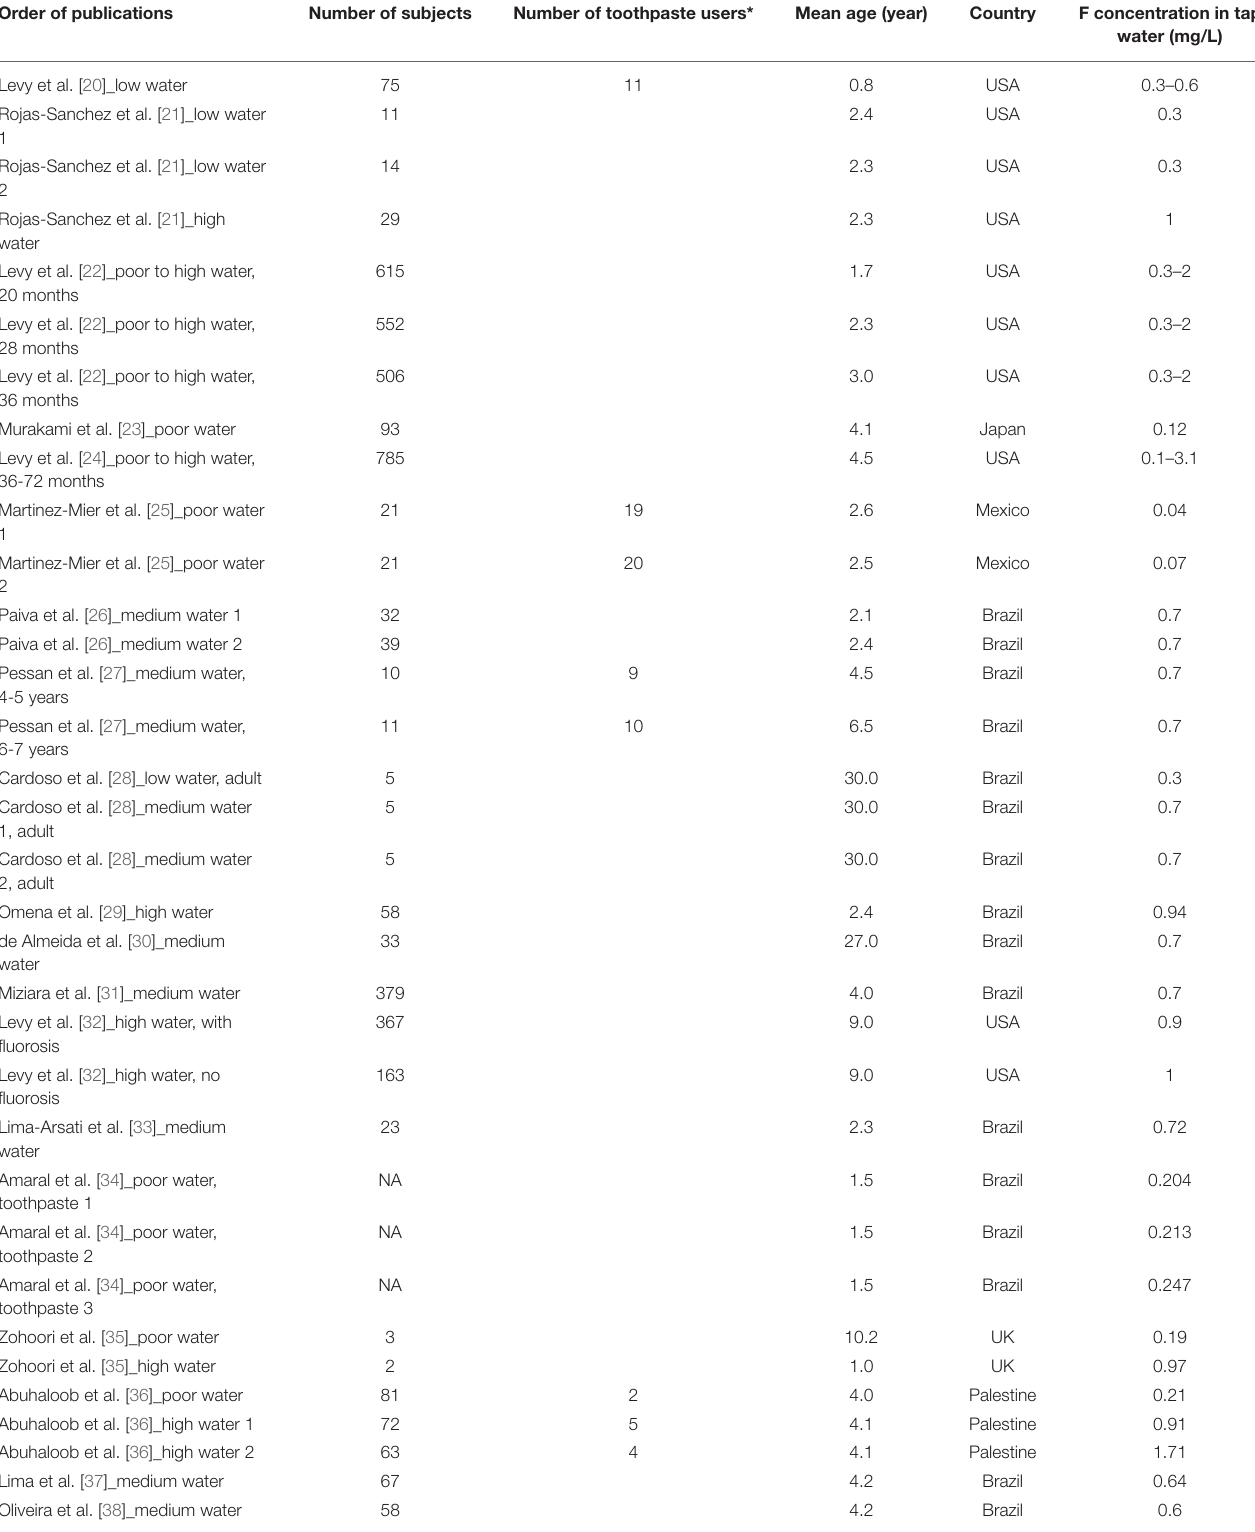
TABLE 1 | Number of participants, their mean age and country of residence, with the associated F concentration in tap water (mg/L) in articles with only estimation of F intake in our Excel database. Order of